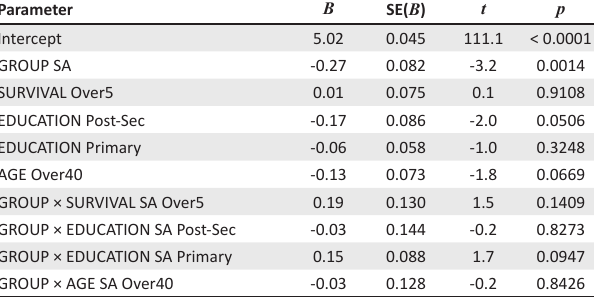
TABLE 13: Parameter estimates for two-way interaction analysis of variance model of charitable work.